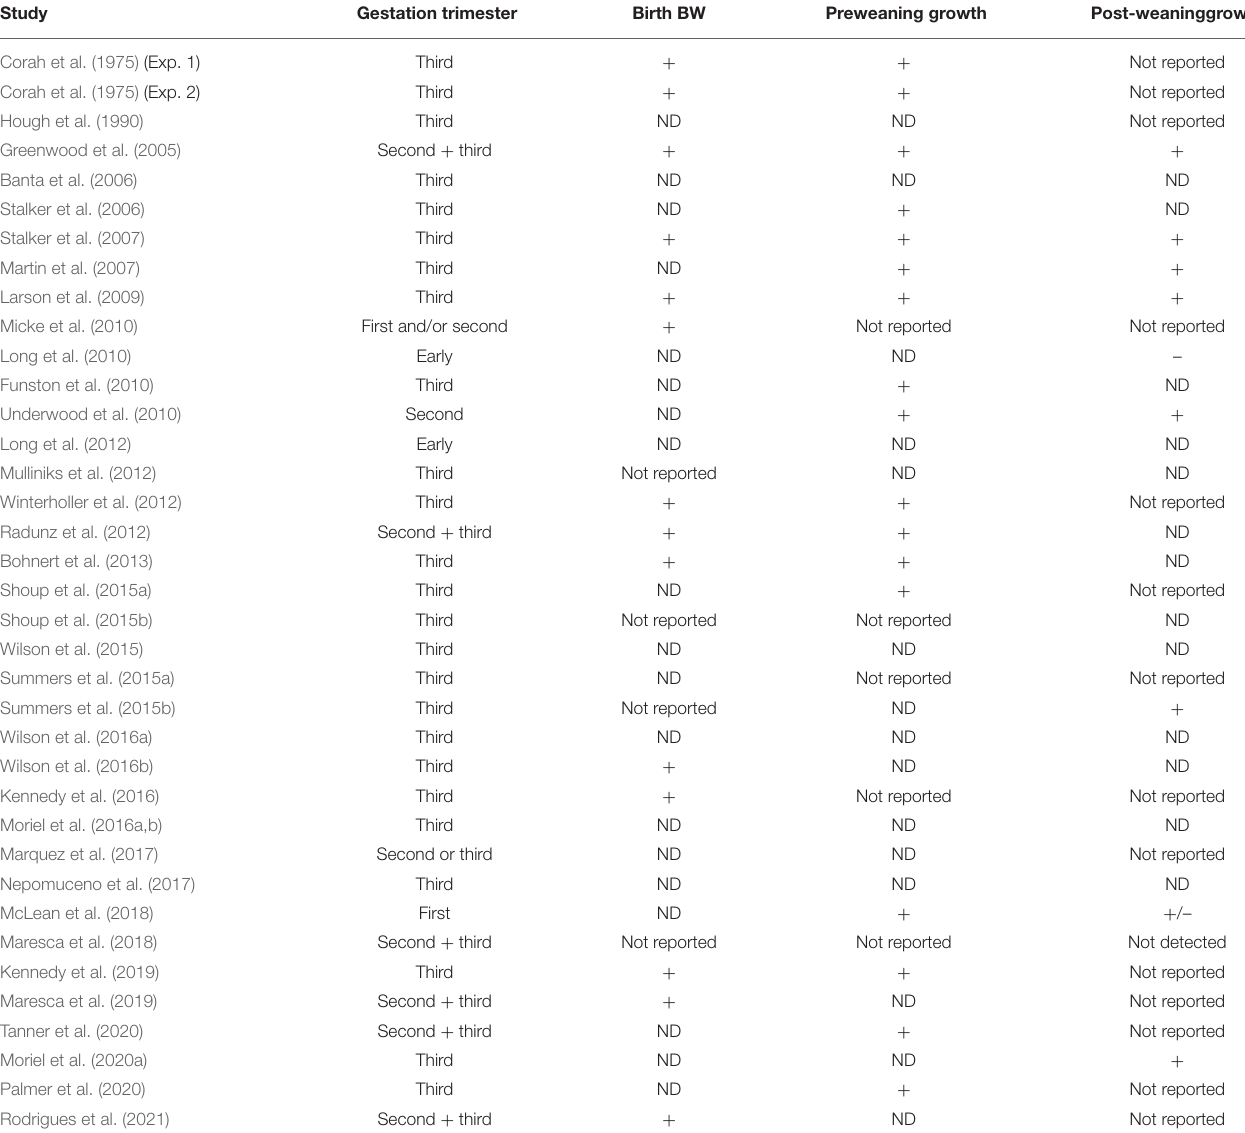
TABLE 1 | Studies ( n = 37) reporting positive ( + ) or negative (–) effects, or no differences (ND; P > 0.10) on beef offspring birth body weight (BW), pre- and post-weaning growth performance following maternal protein and/or energy supplementation during